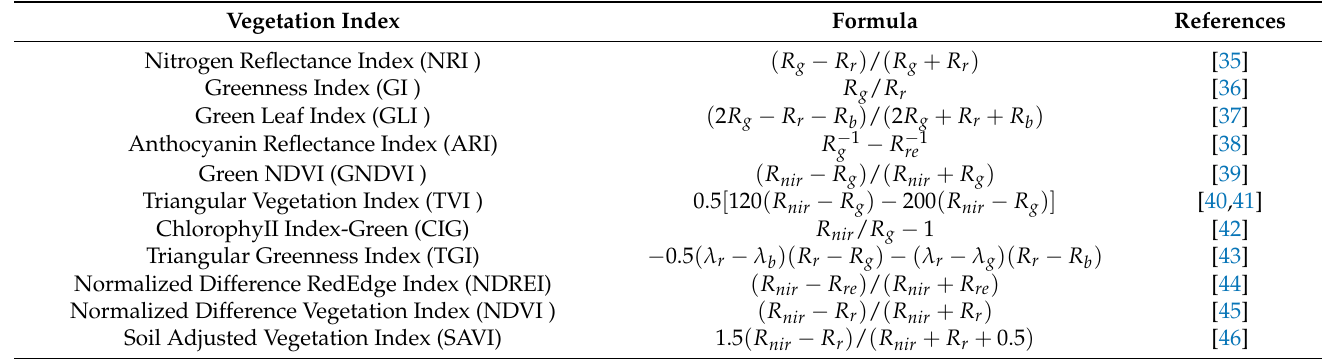
Table 8. List of all SVI details in this